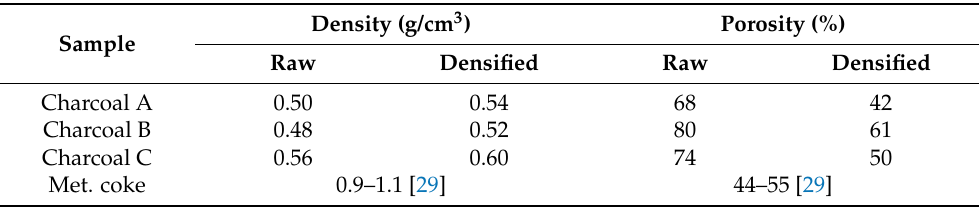
Table 3. Density of charcoal before and after densification. Density of metallurgical coke (met.coke). Density and porosity of the coke was added from other work of the author